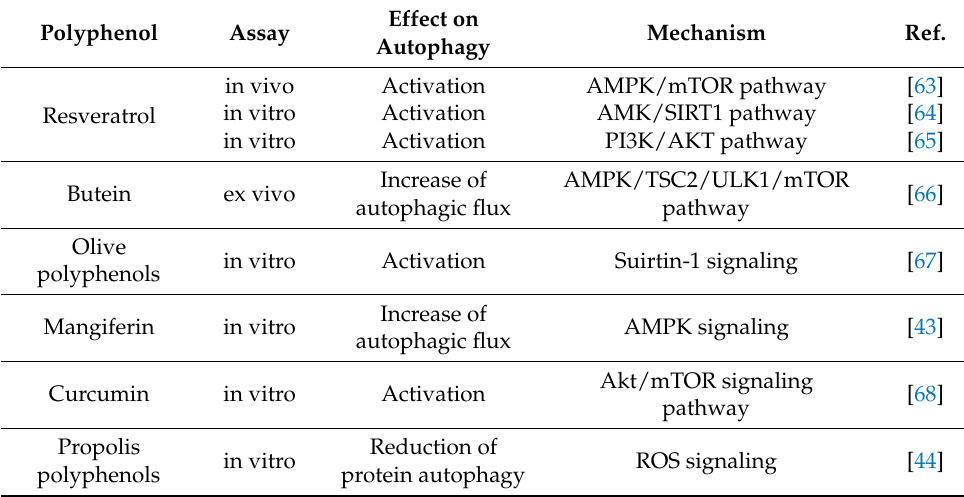
Figure 2. Polyphenols used to regulate autophagy in OA. Table 1. Effects of polyphenols in autophagy in OA model. Table 1. Effects of polyphenols in autophagy in OA